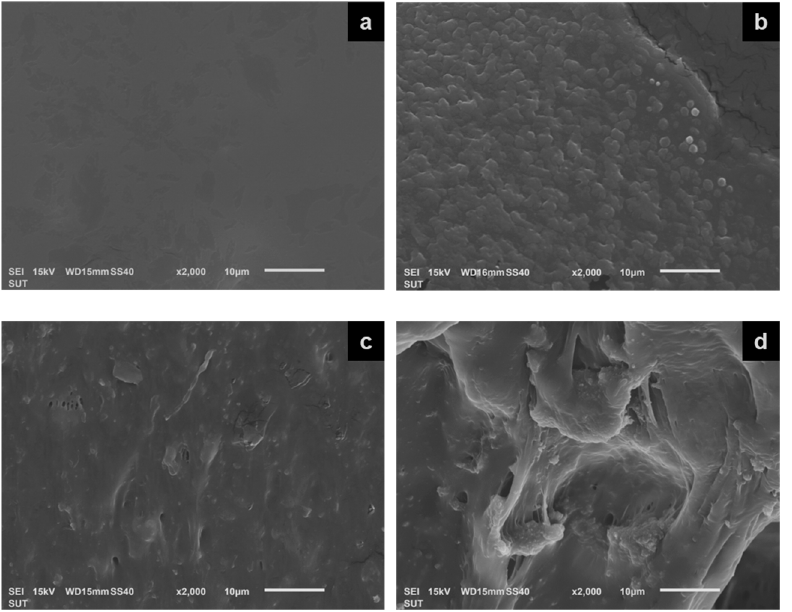
Figure 6. SEM images of cross-section surface of ( a ) M0.50/P30-DPNR, ( b ) M0.50/P30-DPNR/Si10, ( c ) M0.50/P30-DPNR/Si20 and ( d ) M0.50/P30-DPNR/Si30.